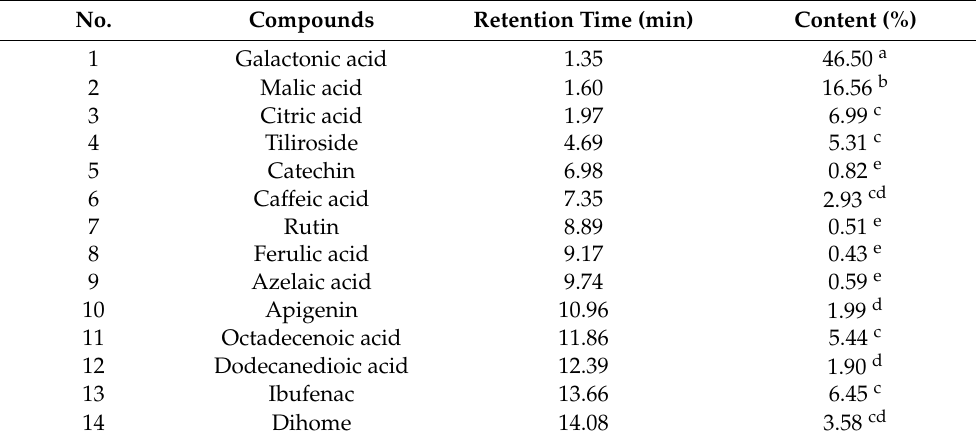
Table 1. Contents of functional compounds from HBWG were identified by UPLC–PAD–MS/MS. No.